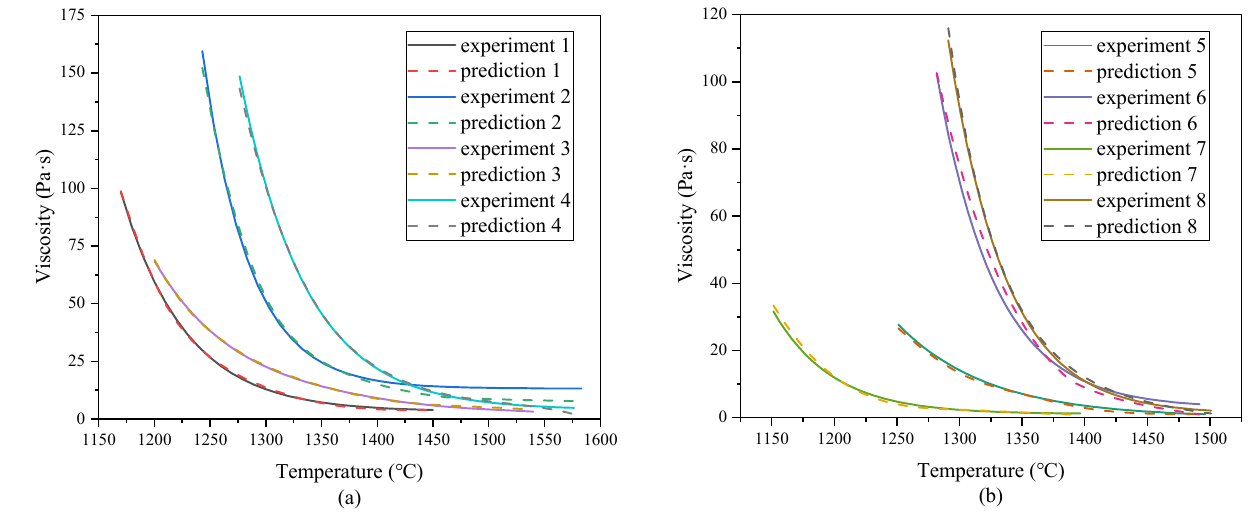
Figure 5. Simulation results: ( a ) low ‐ alkali slag, ( b ) high ‐ alkali slag.